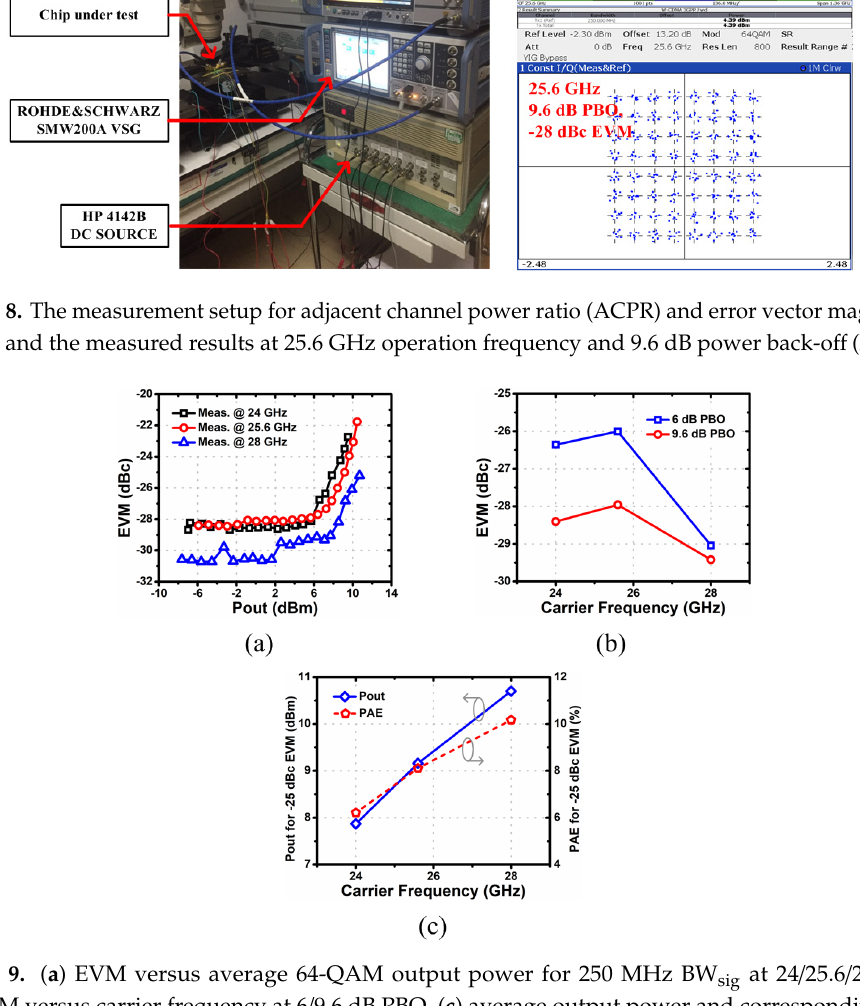
Figure 8. The measurement setup for adjacent channel power ratio (ACPR) and error vector magnitude (EVM) and the measured results at 25.6 GHz operation frequency and 9.6 dB power back-off (PBO).